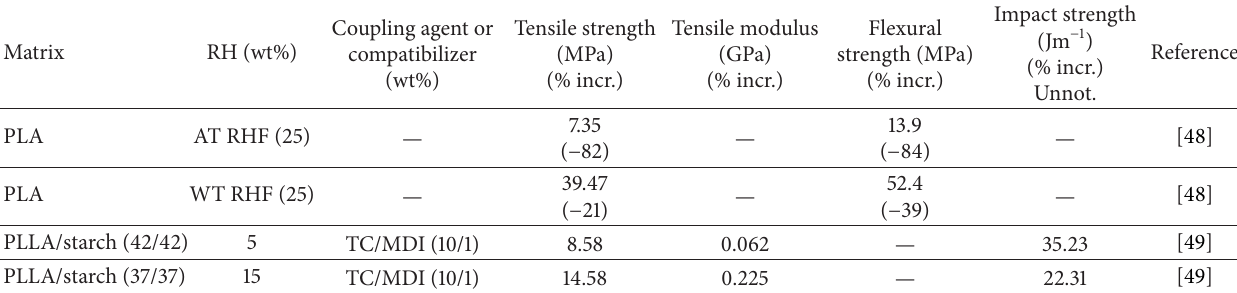
Table 7: Mechanical properties of RH filled PLA composites.